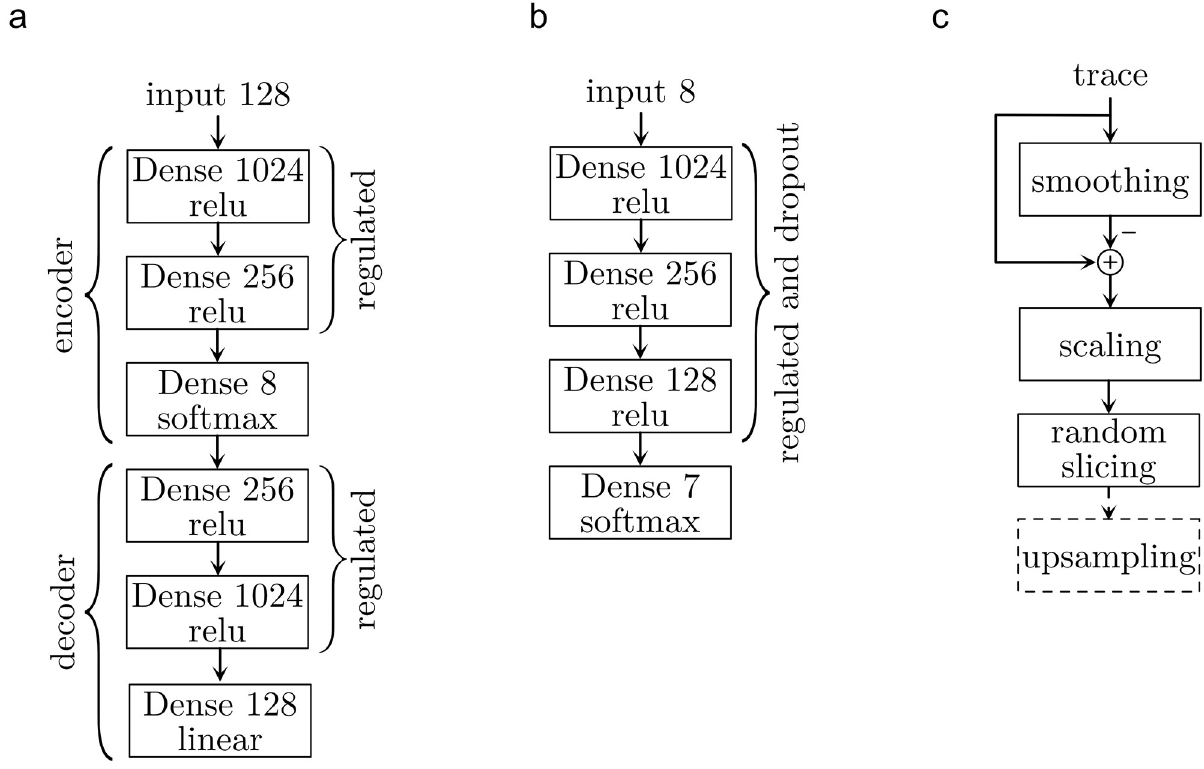
Fig 6. Schematics of the components of an autoclassifier and the data preprocess. a autoencoder model, b classifier model, c data preprocess